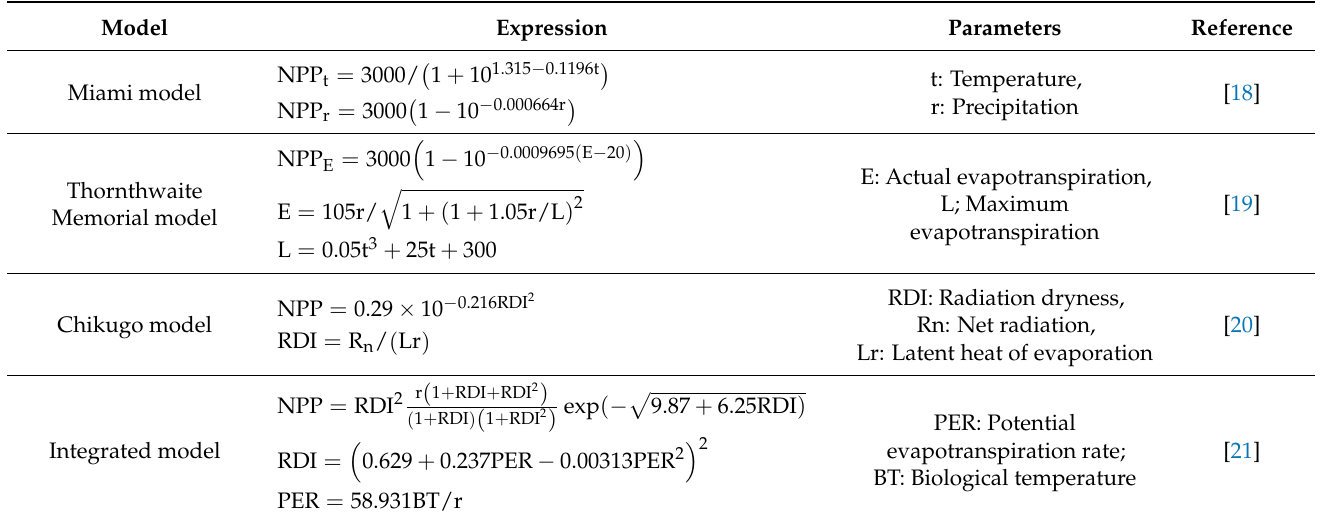
Table 1. Statistical model representative models and their expressions. Please see more details of “Reference” in Appendix